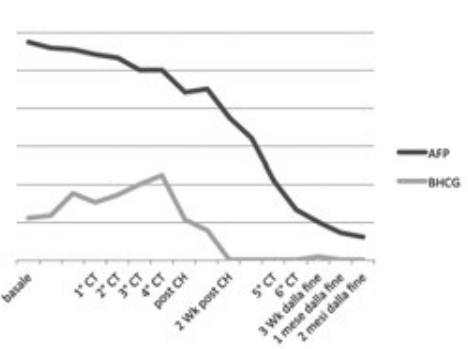
Figura 1. Valori espressi in scala logaritmica.